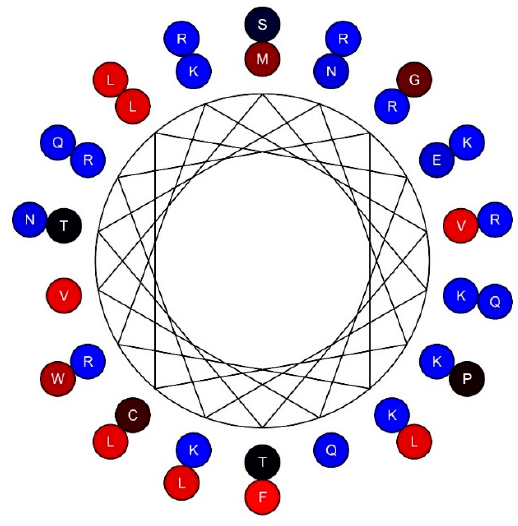
Figure 6. Helical structure of MKK34. A helical wheel projection was constructed using the amino acid sequence of MKK34.